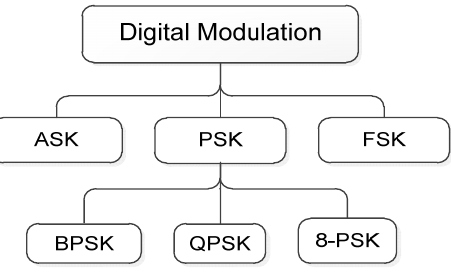
Figure 3. Modulation techniques used in biomedical